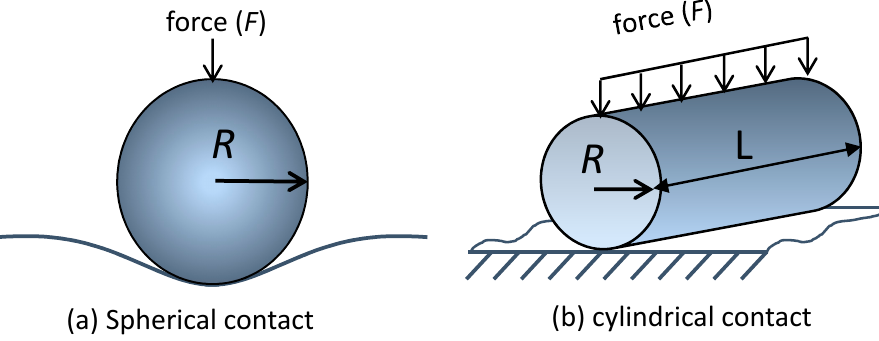
Figure 1. Schematic drawings of ( a ) spherical and ( b ) cylindrical tip contact geometries.